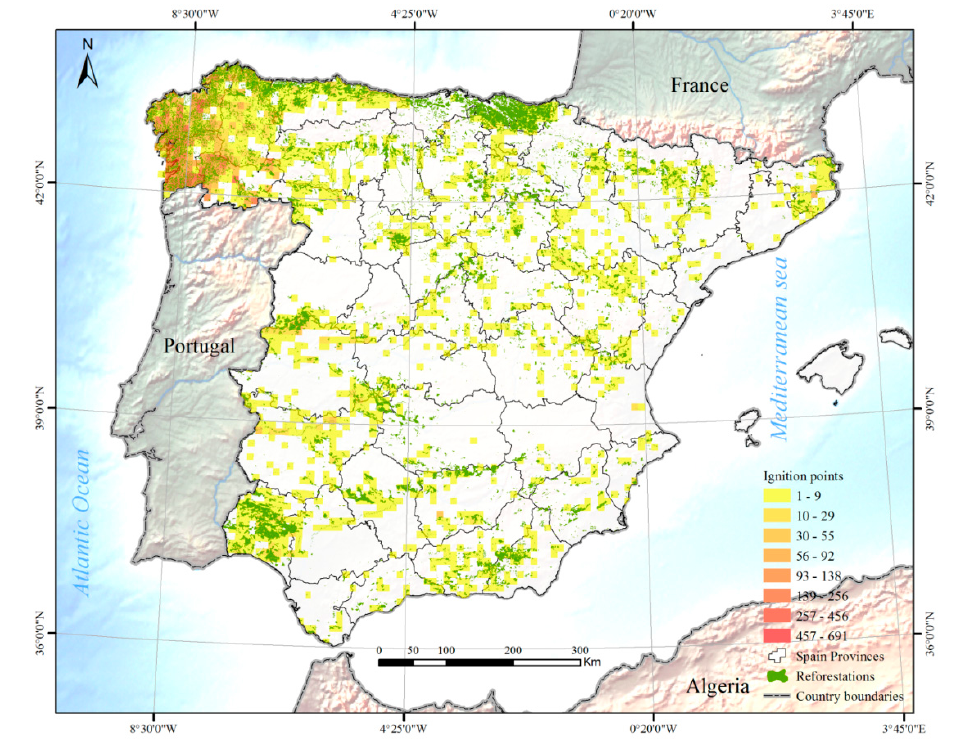
Figure 2. Frequency of ignition points within reforestations in Spain.